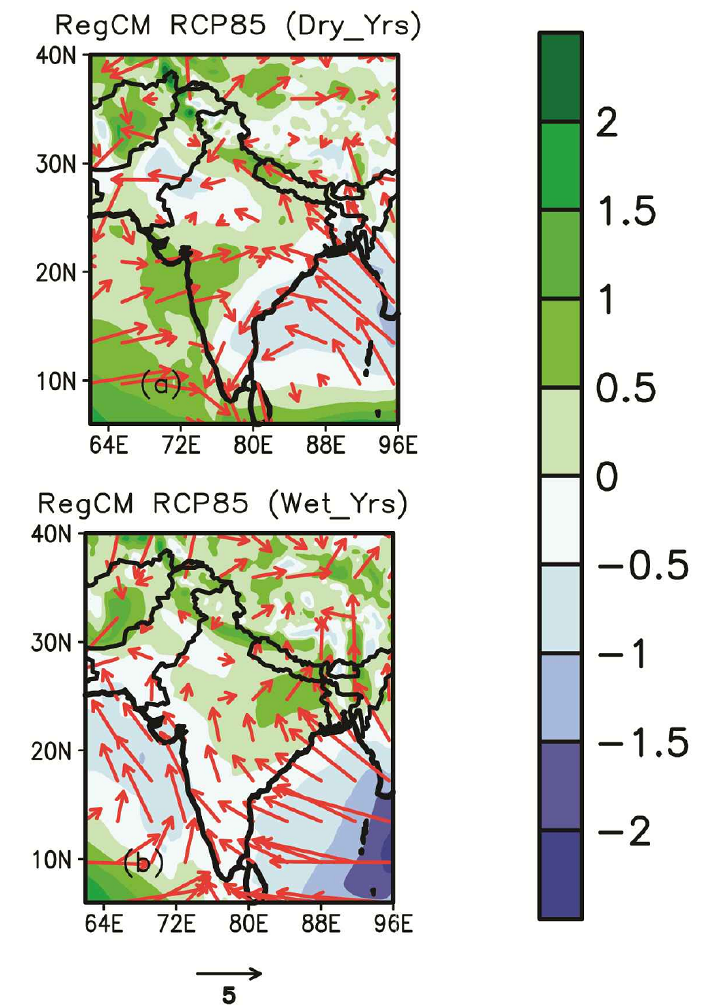
Figure 11. Projected changes (2070–2099 minus 1976–2005) in SASM mean wind speed (shading, m/s) and direction (arrows) at 850 hPa for ( a ) RegCM4 RCP85 (dry period)); ( b ) RegCM4 RCP85 (wet